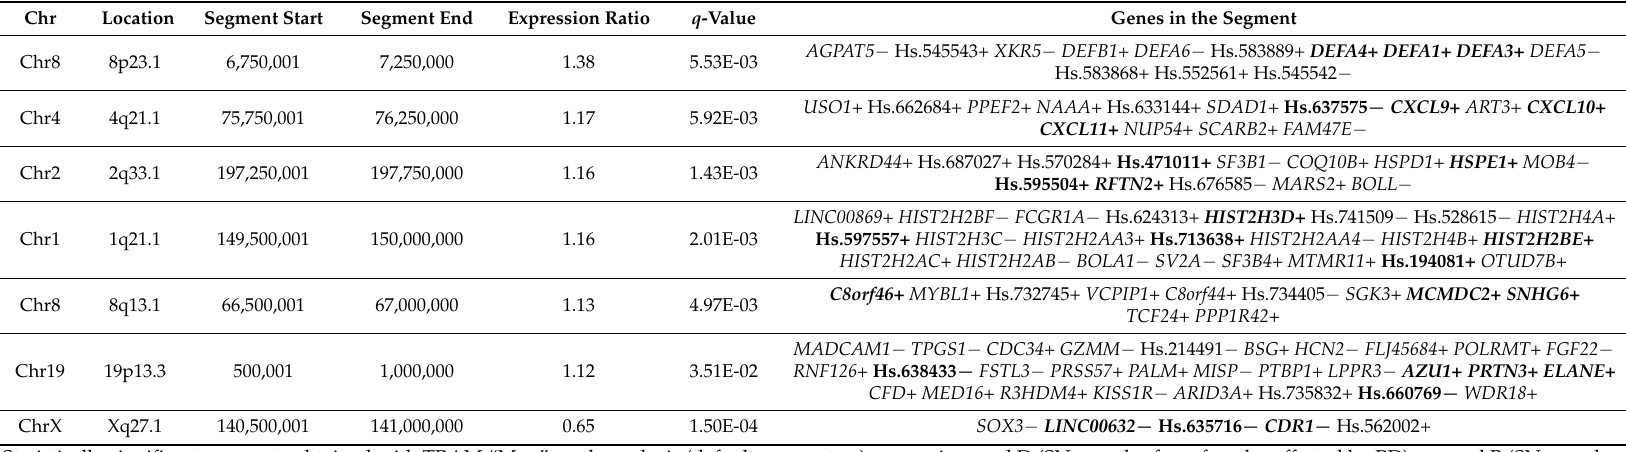
Table 5. Chromosomal segments statistically significant in TRAM “Map” mode analysis of female SN PD patient sample vs. female SN control samples (TRAM